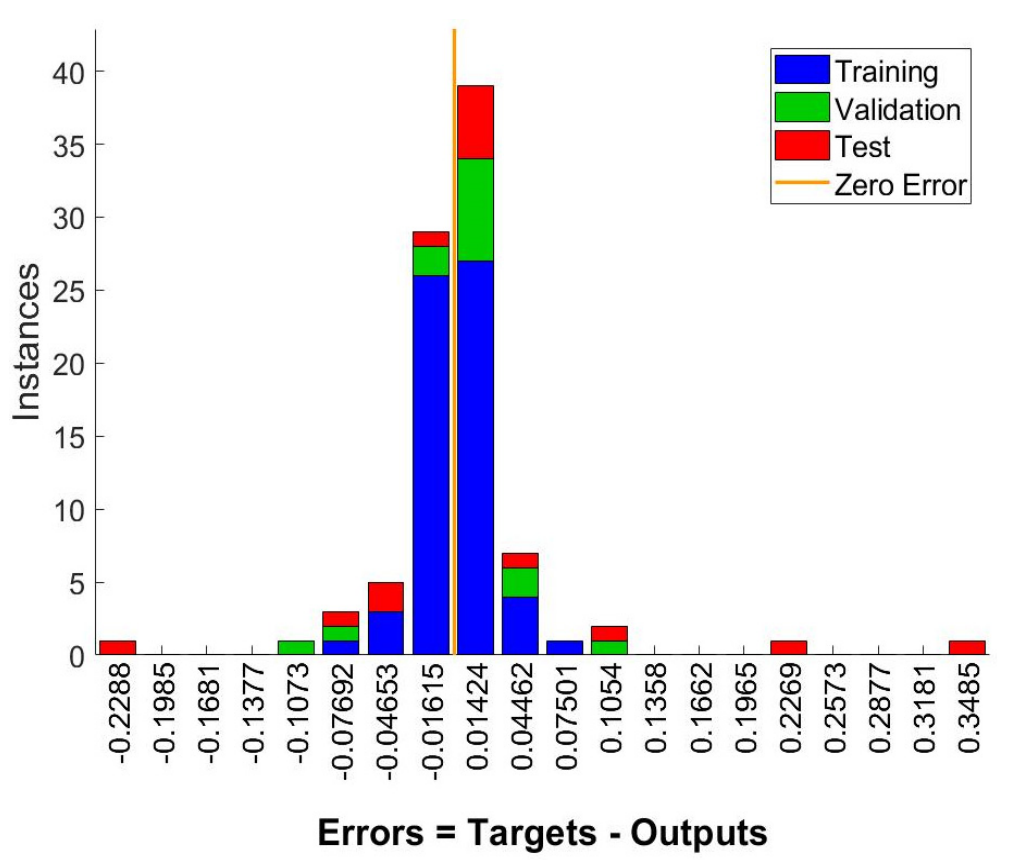
Figure 6. Training phase error histogram.